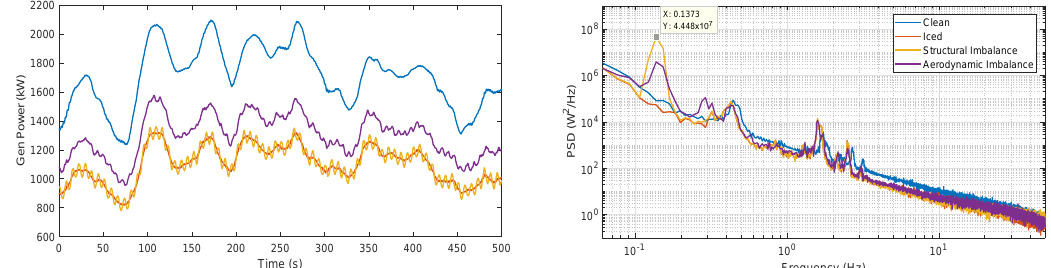
Figure 19. Influence of symmetrical and asymmetrical icing of the blades on the generator power output simulated using a turbulent wind profile over the rotor area.